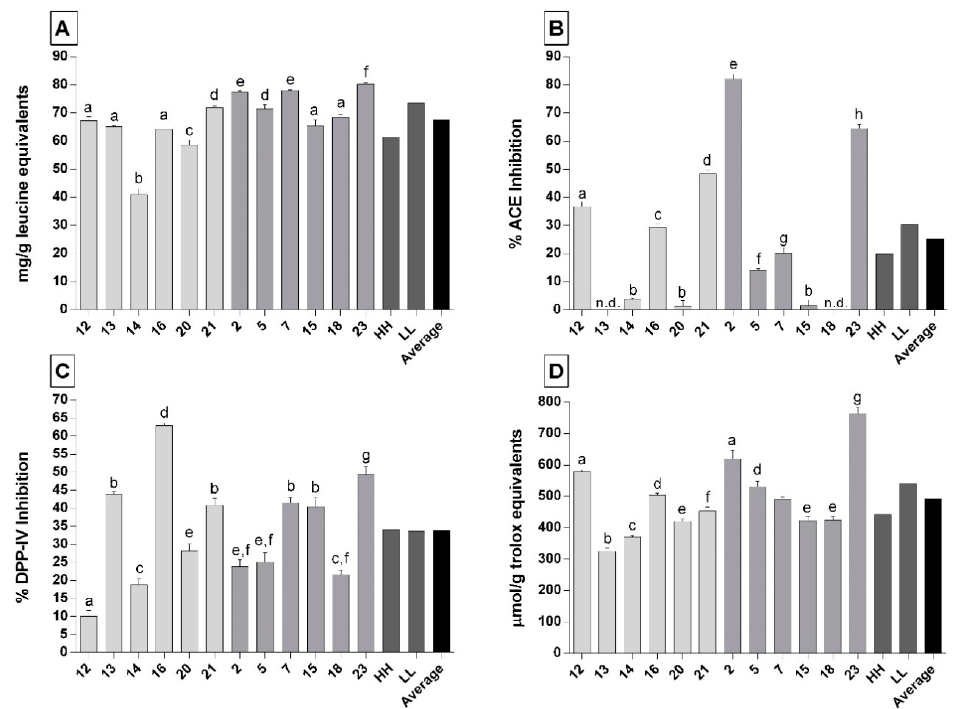
Figure 1. Total peptides concentration and biological activities of 12-month ripened Parmigiano-Reggiano (PR) peptide fractions. ( A ) Total peptides concentration. ( B ) Angiotensin-converting enzyme inhibitory activity. ( C ) Dipeptidyl-peptidase IV-inhibitory activity. ( D ) Antioxidant activity. Light grey bars represent PR samples belonging to the high-salt and high-fat group (HH). Dark grey bars represent PR samples belonging to the low-salt and low-fat group (LL). HH represents the average values, considering the samples belonging to the high-salt and high-fat group. LL represents the average values, considering the samples belonging to the low-salt and low-fat group. Average represents the mean values considering all of the 12 PR samples. The x-axis reports the code number of PR samples. Values are means of three assay replications ± standard deviation (SD). Di ff erent letters indicate significantly different values ( p < 0.05 ).